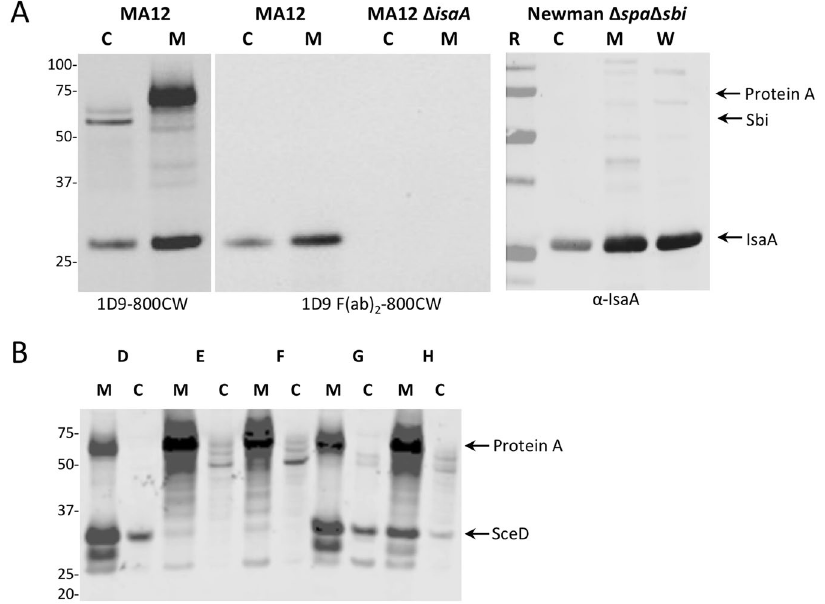
Figure 2. Cell-associated and secreted forms of IsaA and SceD. ( A ) S . aureus MA12, S . aureus MA12 Δ isaA and S . aureus Newman Δ spa Δ sbi were grown overnight. Subsequently, cells (C) were separated from the growth medium (M) by centrifugation and proteins in the respective fractions were separated by LDS-PAGE. In addition, non-covalently cell wall-associated proteins (W) were extracted from S . aureus Newman Δ spa Δ sbi and separated by LDS-PAGE. The presence of IsaA was subsequently visualized by Western blotting using humAb 1D9-800CW, hum Ab 1D9 F(ab) 2 -800CW or the polyclonal rabbit antibody α -IsaA. Molecular weights (kDa) of marker proteins are shown on the left and the positions of Protein A, Sbi and IsaA are indicated on the right. ( B ) Cellular ( C ) and secreted proteins in the growth medium (M) of the clinical S . aureus isolates ( D , E , F , G and H ) were separated by LDS-PAGE and detected by Western blotting using an α -SceD polyclonal antibody. Molecular weights (kDa) of marker proteins are shown on the left and the positions of protein A and SceD are indicated on the